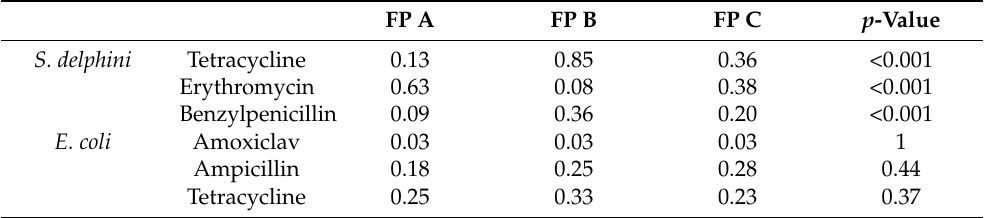
Table 7. Antibiotic non-wildtype among Staphylococcus delphini and Escherichia coli isolated from Danish mink from 2018–2019. Association between the proportions of antibiotic non-wildtype isolates and affiliated feed producers ( χ 2 − /Fisher’s exact-test